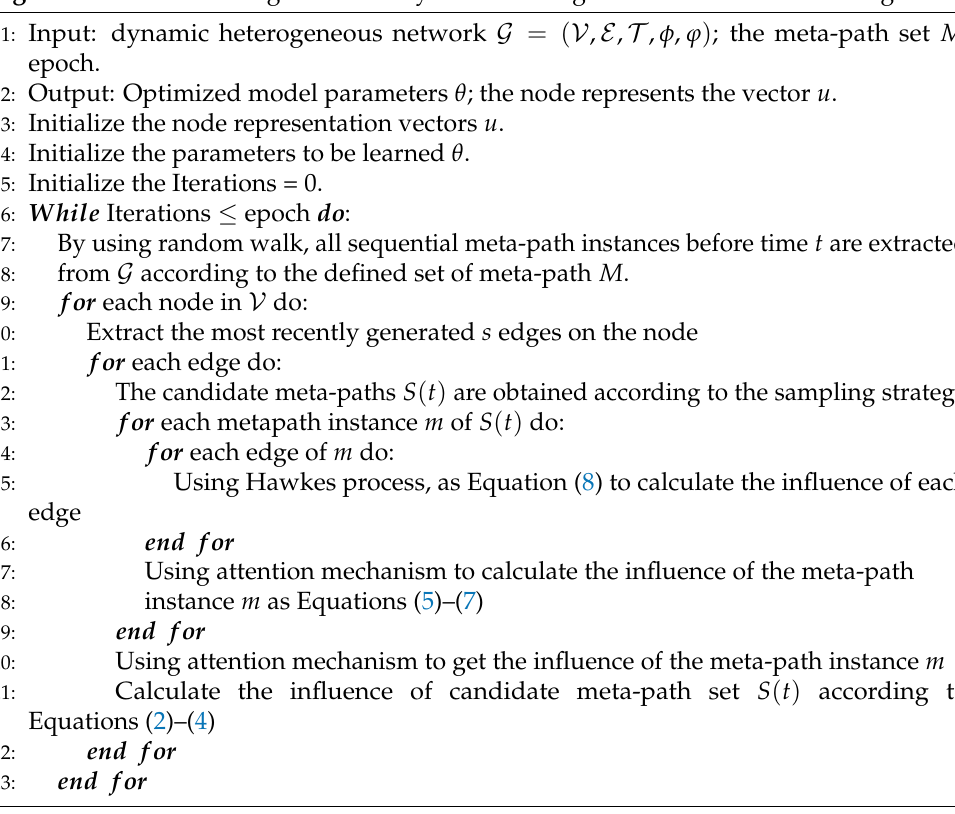
Algorithm 1 DEGEEP: Algorithm for dynamic heterogeneous network